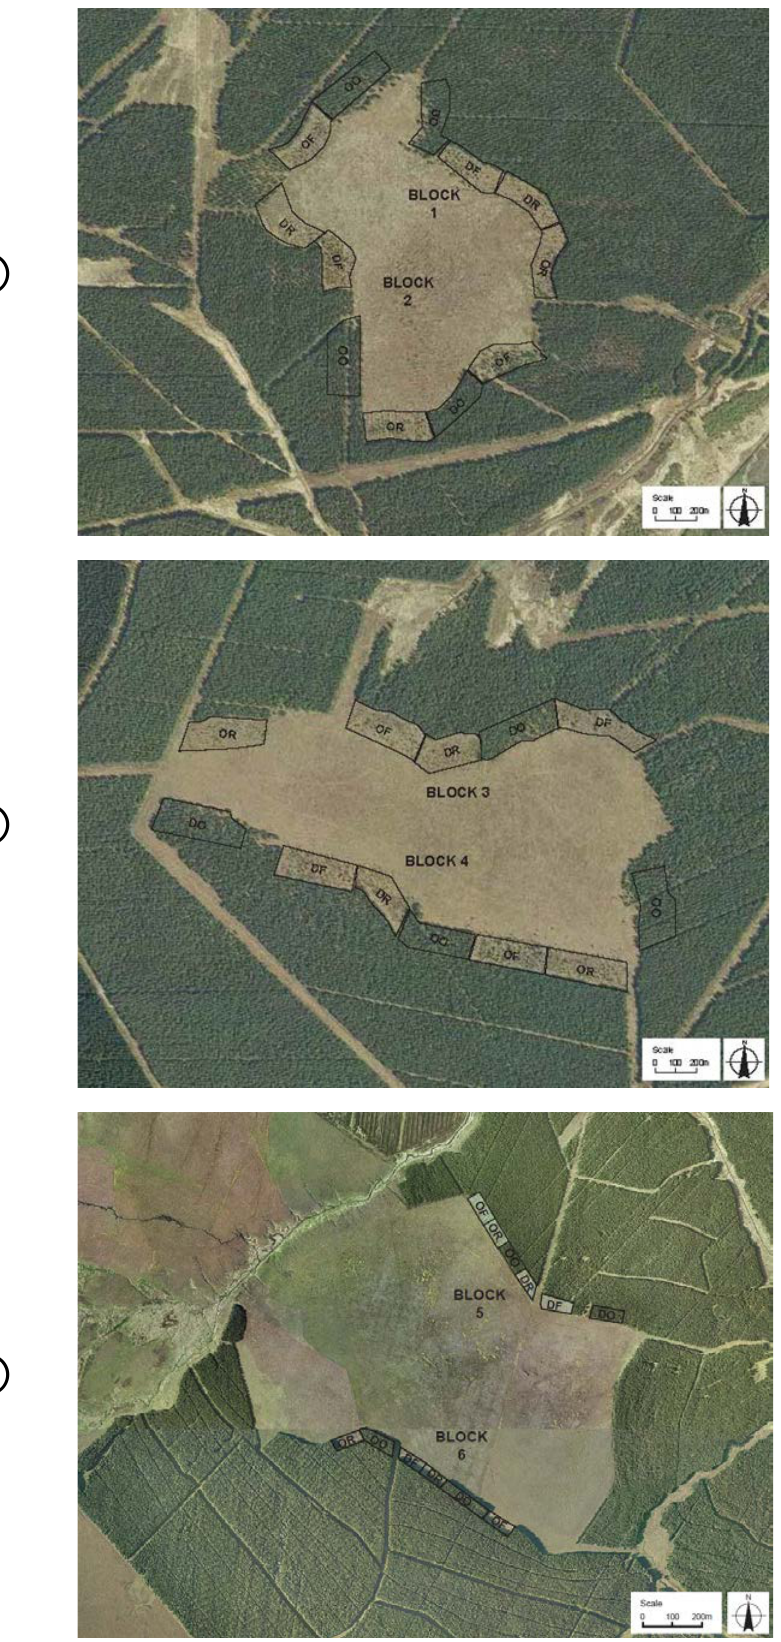
Figure 2. Aerial photographs showing the layout of blocks and plots at (a) Halsary South, (b) Halsary North and (c)